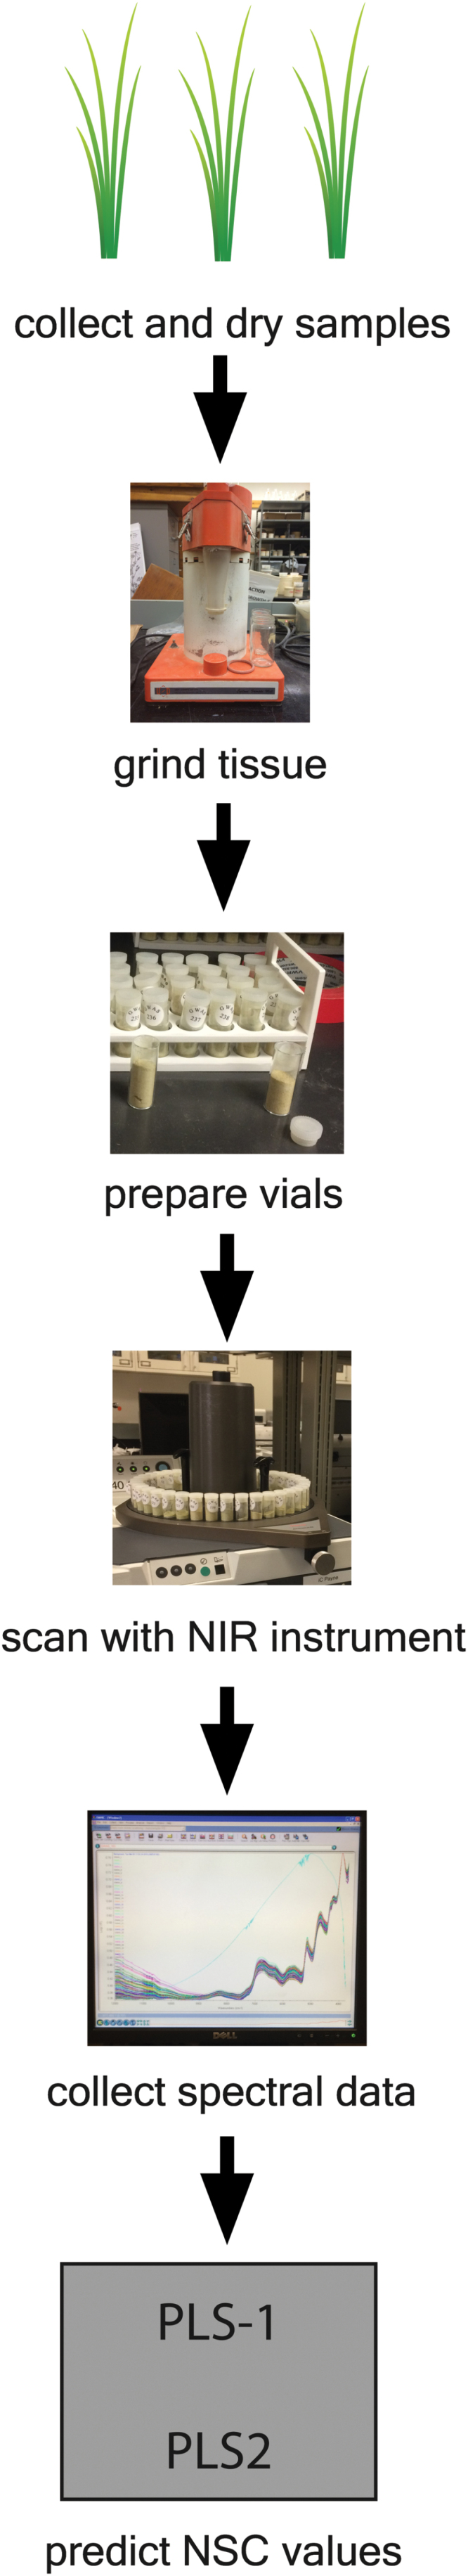
NIR protocol for assaying rice stem NSC. Steps taken for using near-infrared spectroscopy for rapid determination of rice stem NSC components. (This figure is available in color at JXB online.)